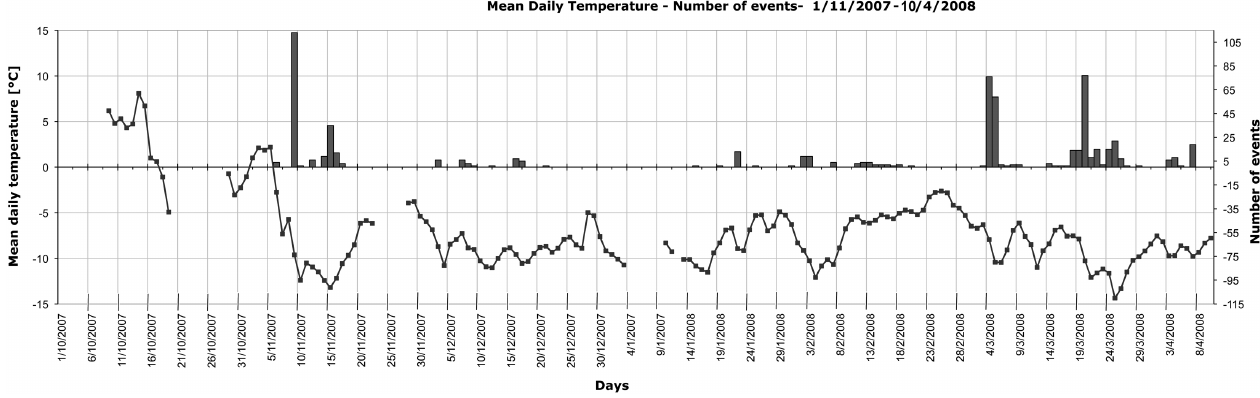
Fig. 9. Graph of the total number of events per day and the daily temperature trend: continuous line represents daily temperature trend; histogram represents daily number of